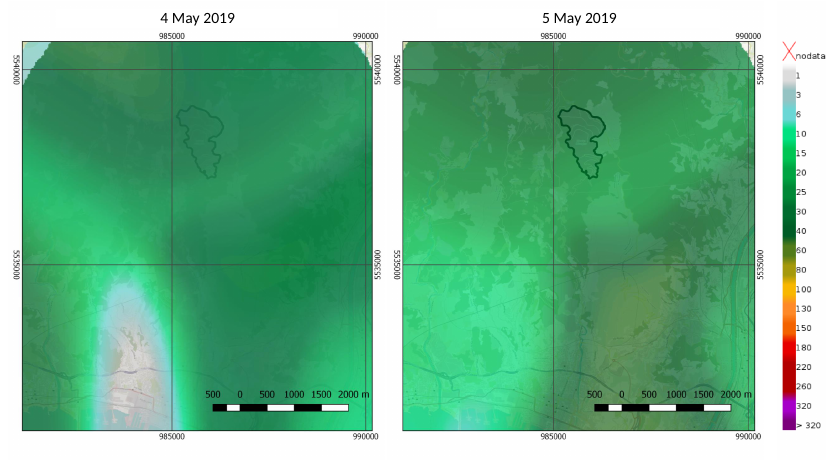
Figure 5. Daily rain accumulation maps produced by the SRS system for the event of 4 − 5 May 2019, at the Monte Scarpino landfill. The landfill area is highlighted by the black contour. The unit of the colorbar is [ mm/h ]